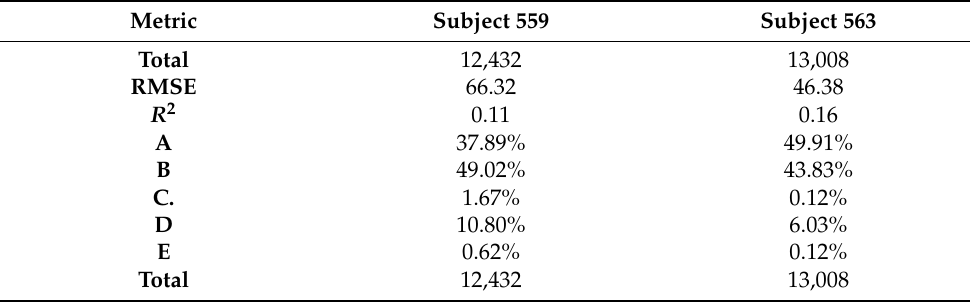
Table 3. Summary of the studied metrics for Subject 559 and